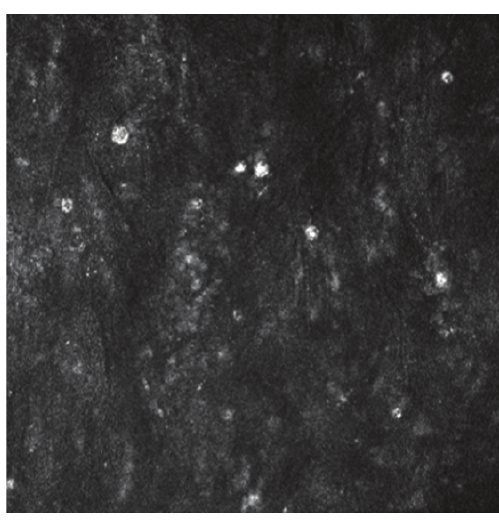
Figure 1: In vivo corneal confocal microscopy: amoeba cysts seen as round hypereflective